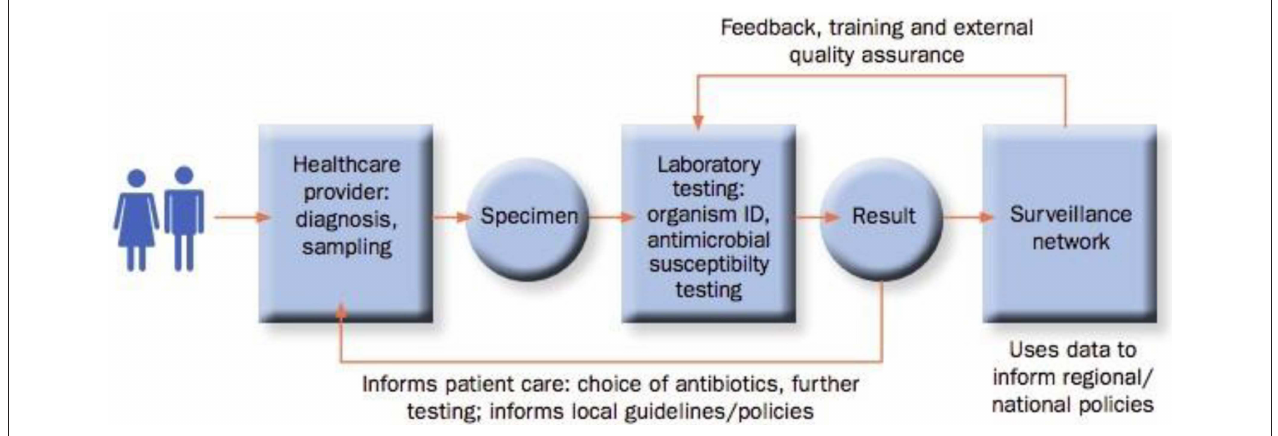
FIGURE 1 | Local AMR surveillance process (source: